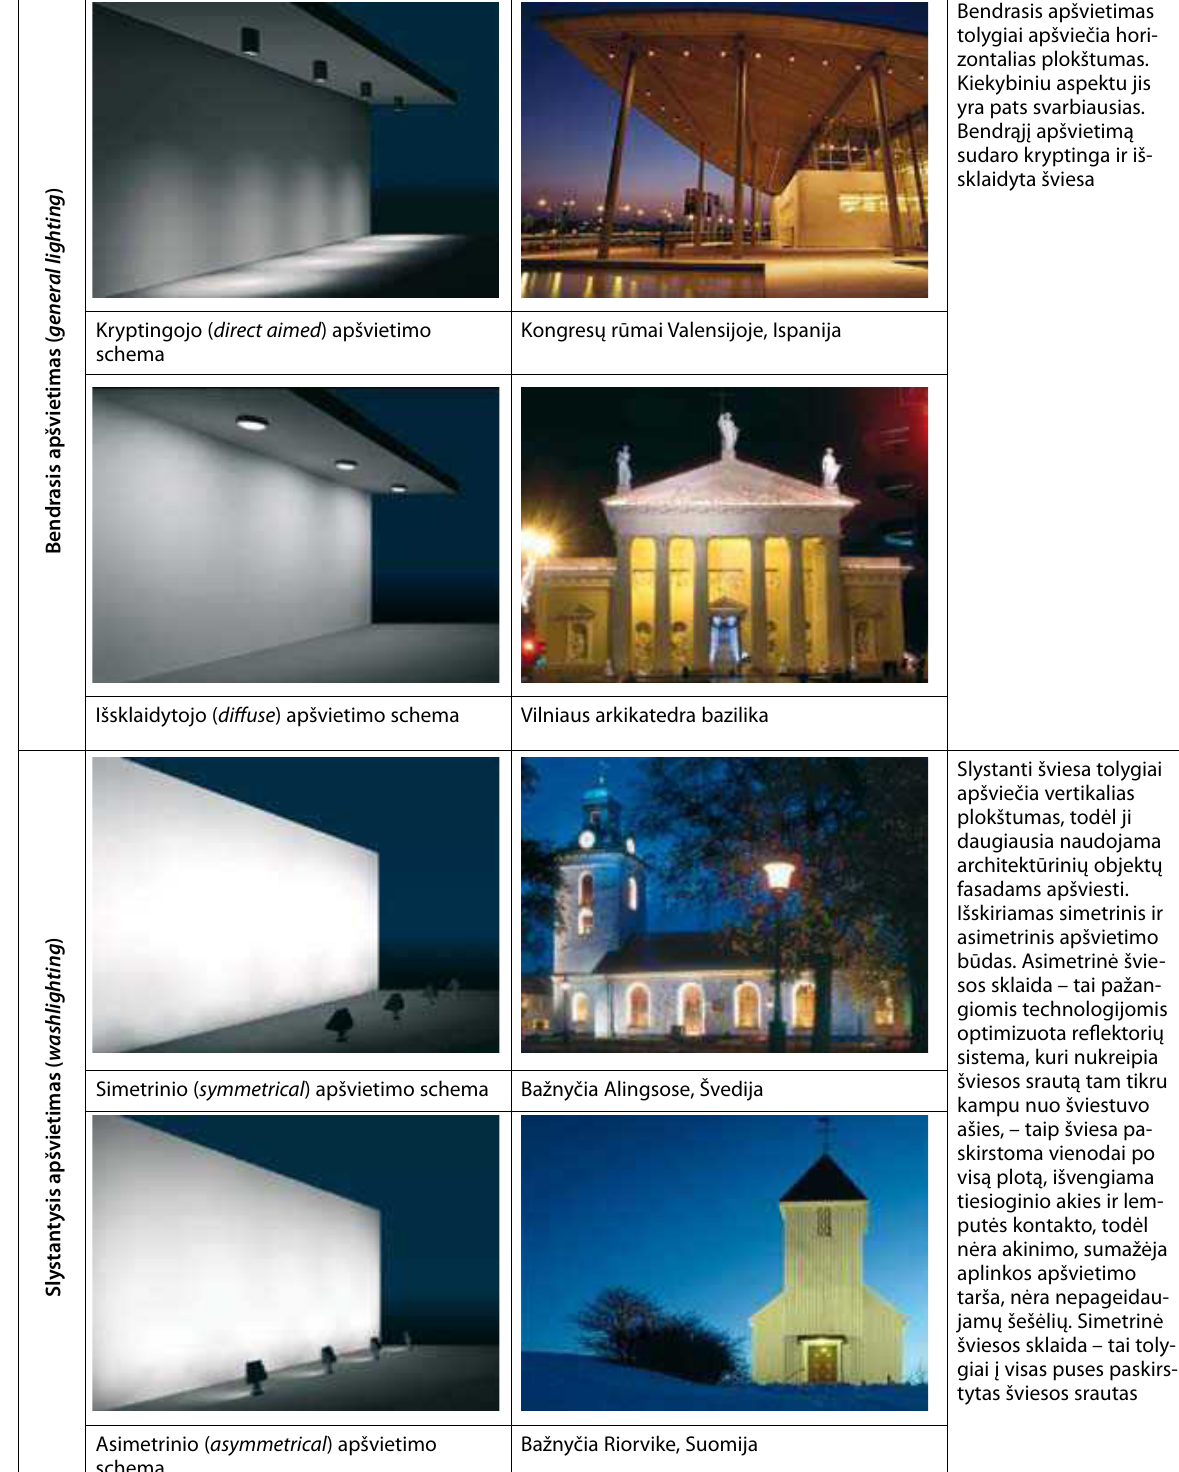
Table 1. Types of lighting by